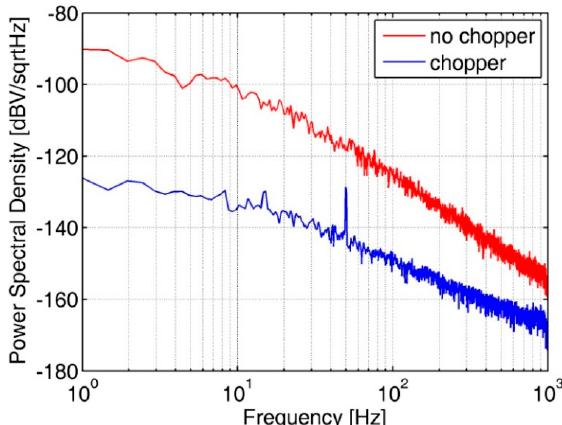
Figure 10. Noise PSD of the bandgap voltage reference at 175 °C. Table 1. Performance of Bandgaps.